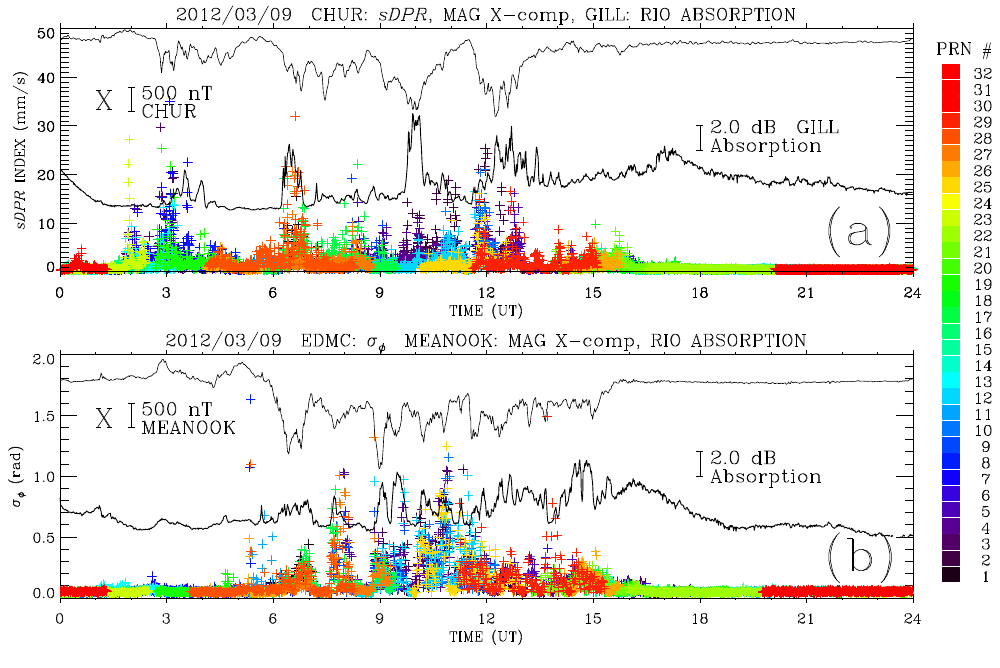
Figure 10. Same as in Fig. 5a and b but for 9